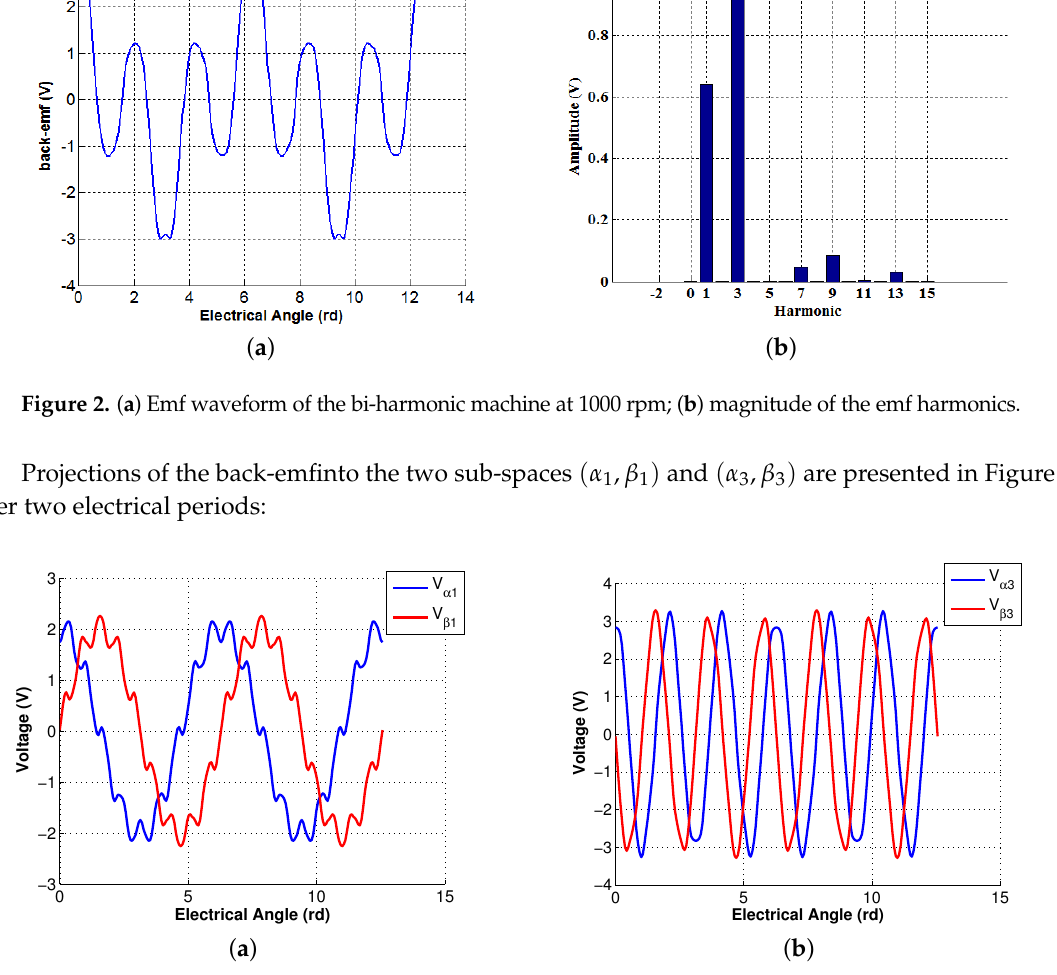
Figure 3. Projection of the back-EMF in: ( a ) ( α 1 , β 1 ) primary sub-space; ( b ) ( α 3 , β 3 ) the secondary